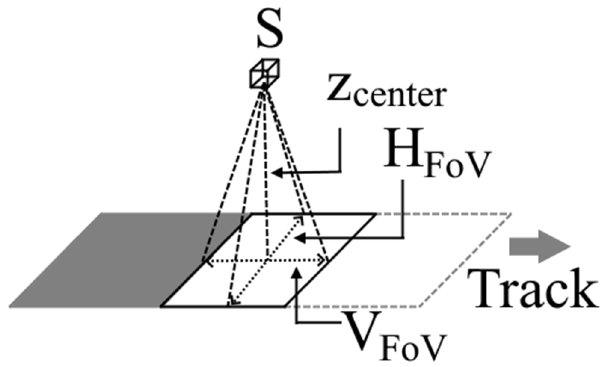
Figure 3. Calculation for the horizontal (H FoV ) and vertical (V FoV ) field of view (FoV) with respect to the sensor (S) and the aircraft-ground separation below the central pixel (Z center ).